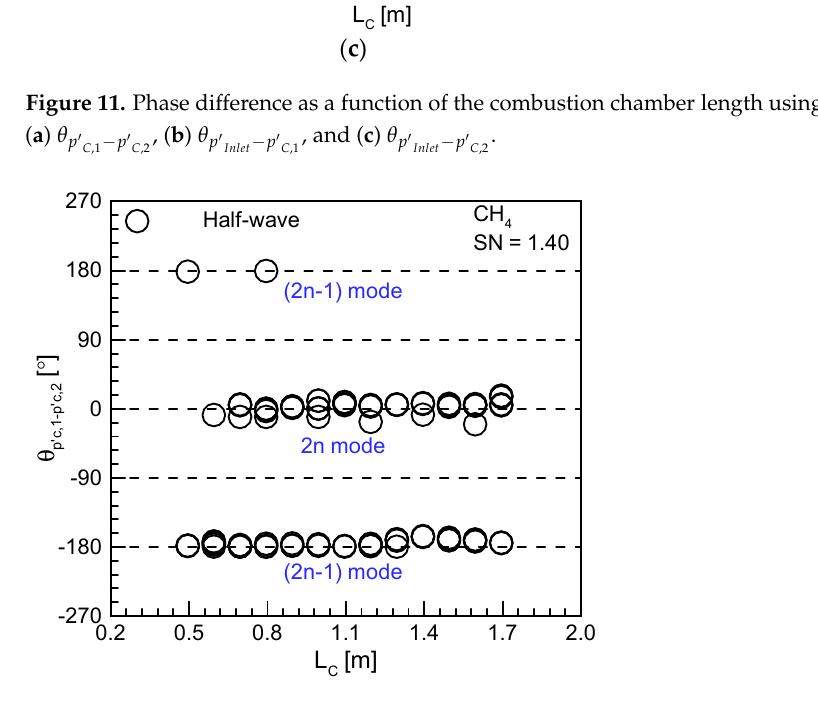
) as a function of the combustion chamber length using CH 4 (cid:4594) at − p (cid:48) (cid:3252),(cid:3117) (cid:2879)(cid:3043) (cid:3252),(cid:3118) C ,1 C ,2